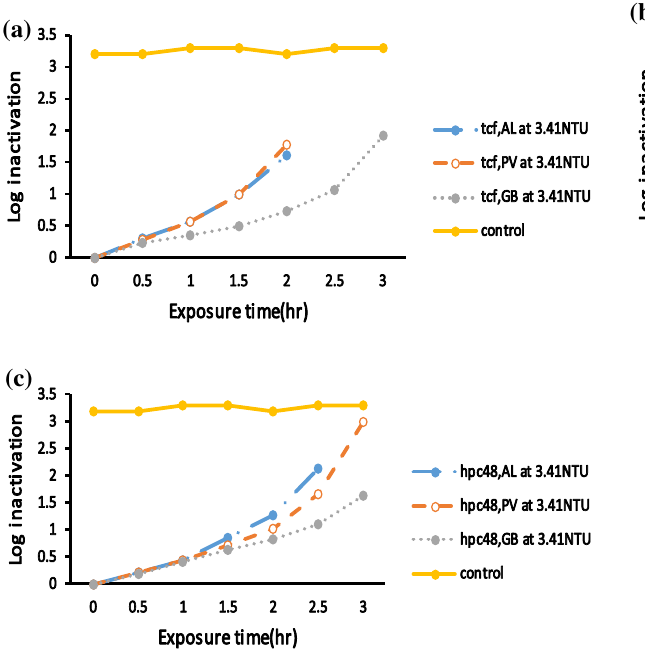
tors for E. coli inactivation; c comparison between concentrators for heterotrophic plate count at 35 °C for 48-h